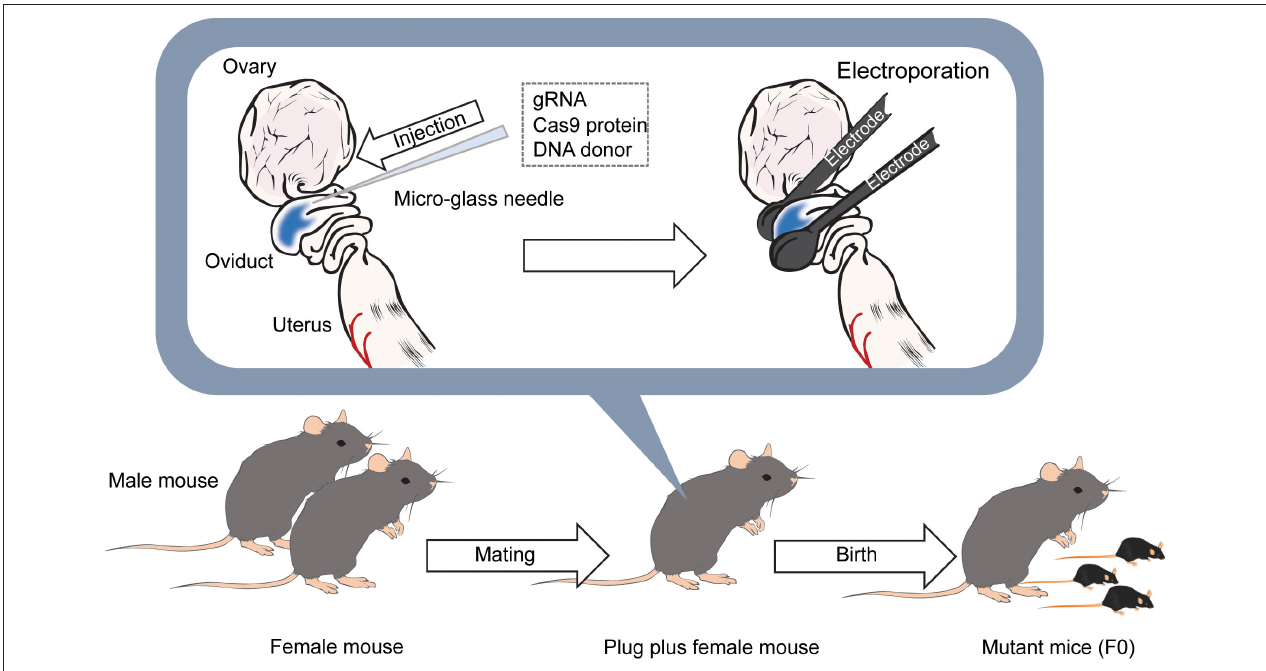
FIGURE 4 | Diagram of the iGONAD method. The day after the mating, gRNA and Cas9 protein is injected into the ampulla of the oviducts of female mice with confirmed plugs using a micro-glass needle. DNA donors are also injected into the ampulla when generating knockin mice. After that, electrodes are placed between the oviducts, and pulses are applied. After 18–20 days later, F0 mice are